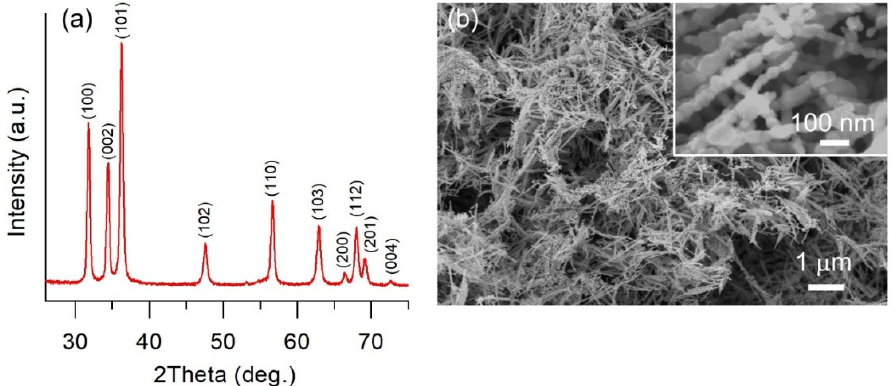
Figure 1. ( a ) X-ray diffraction (XRD) pattern of the ZnO nanomaterial obtained on a silicon substrate, ( b ) SEM images of the ZnO nanomaterial with different magnifications. Table 1. Table of the quantitative analysis of the ZnO nanomaterial obtained by Energy-dispersive X- ray (EDX).